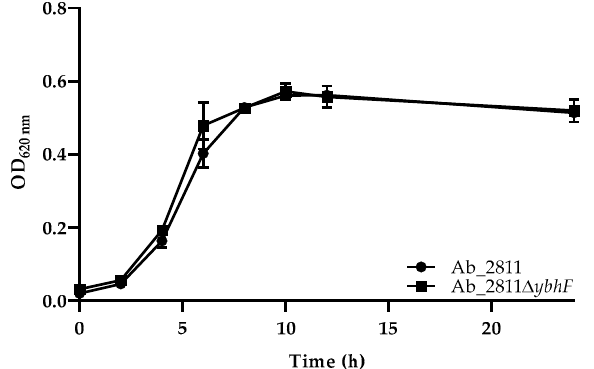
Figure 1. Growth curves of the parental strain Aliarcobacter butzleri Ab_2811 and derived mutant strain Ab_2811 ∆ ybhF . Data correspond to mean ± standard deviation (SD) of two independent trials.